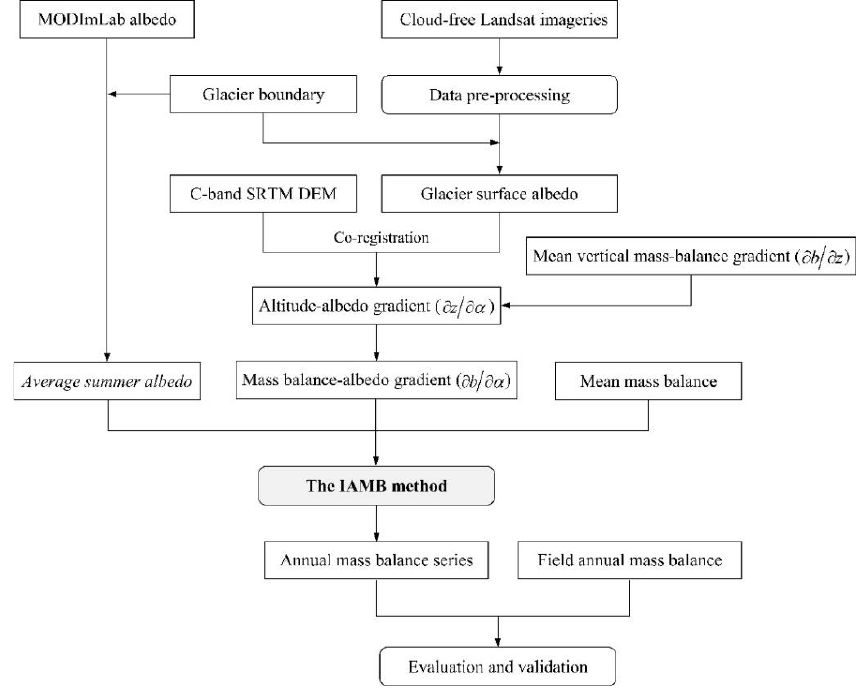
Figure 2. Overall workflow for the IAMB method used to reconstruct the annual mass balance in this study.